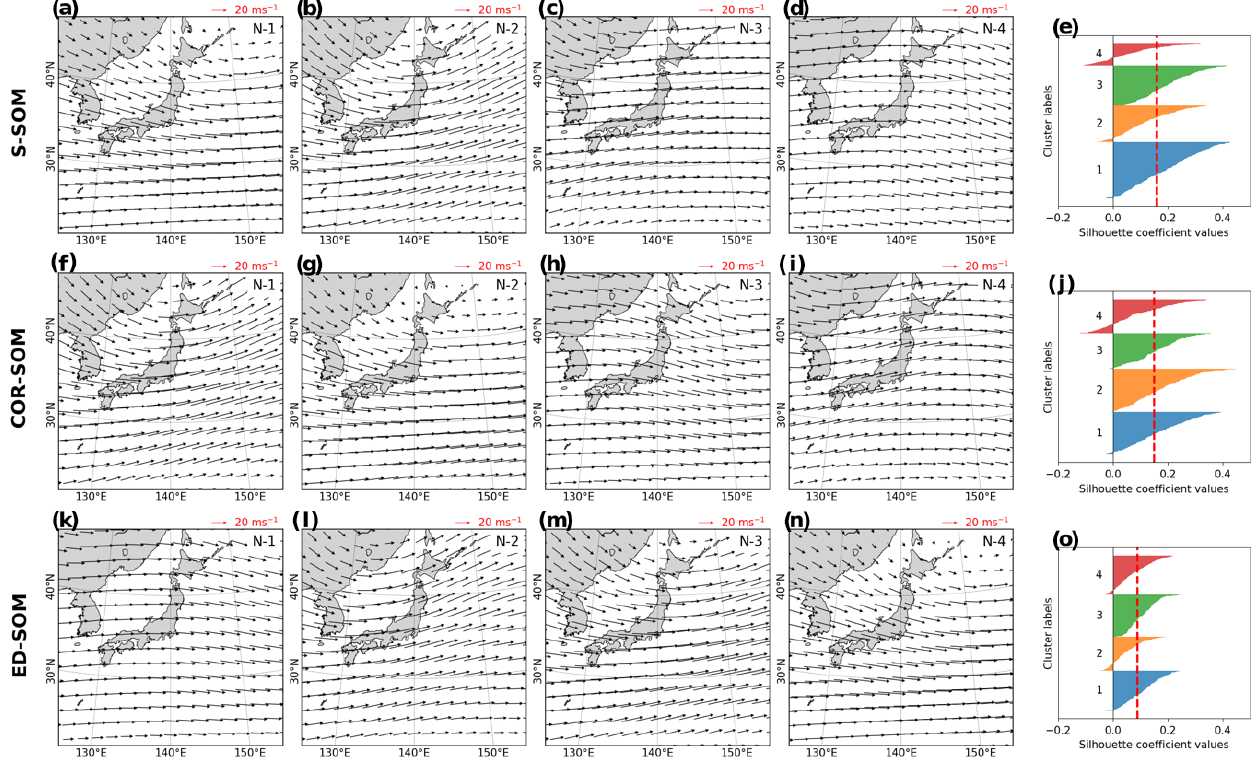
Figure A8. Spatial patterns of the winter 500hPa wind vector pattern revealed by SOMs with the size of 4. Panels (a) – (c) show the S-SOM results and panel (d) shows the silhouette analysis plot; panels (f) – (j) show the same results but for COR-SOM and (k) – (o) for ED-SOM.